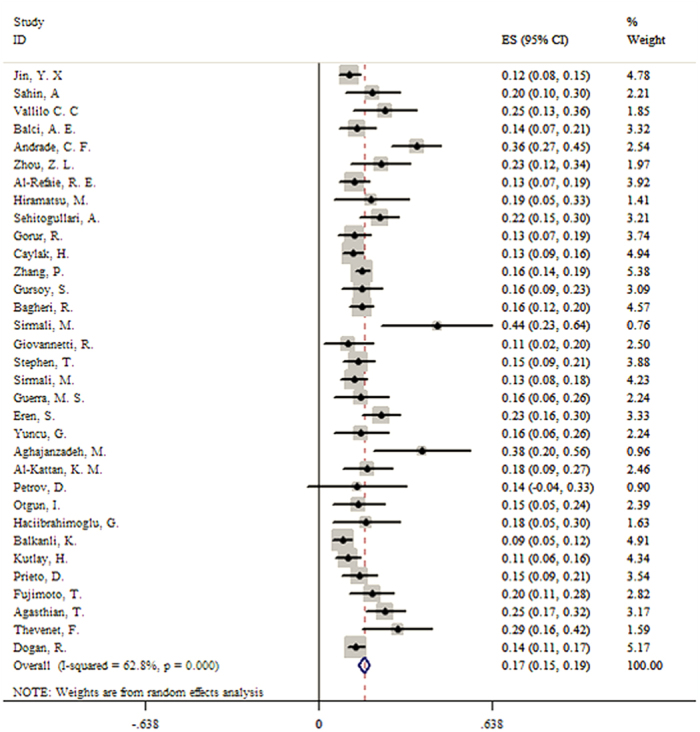
Forest plot assessed morbidity of surgery for the treatment of non-CF bronchiectasis.